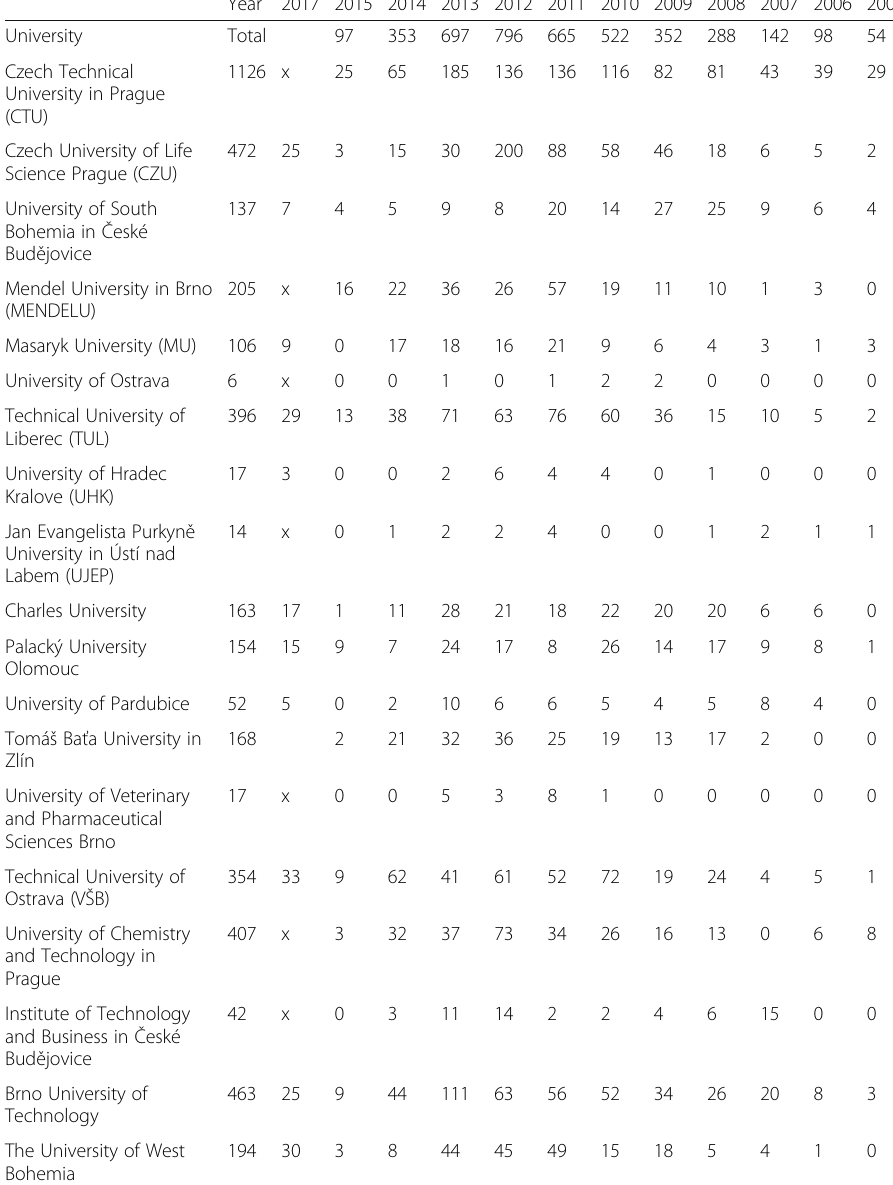
Table 1 Distribution of filed patent documents in the last 10